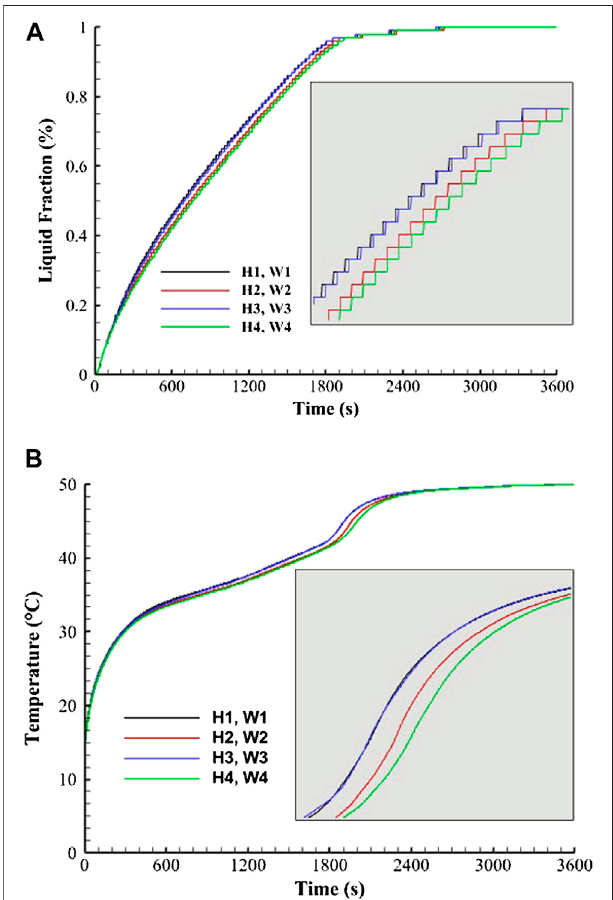
FIGURE 7 | (A) Liquid fraction development; (B) temperature pro fi le for various dimensions of the T-shaped fi n ’ s head (the sizes of the fi n ’ s body are the same).